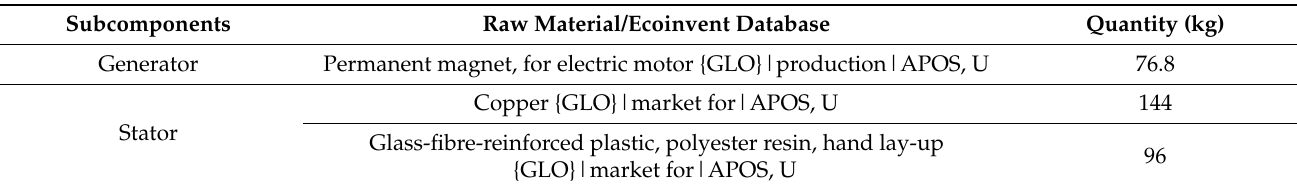
Table A3. Generator inventory and matching Ecoinvent